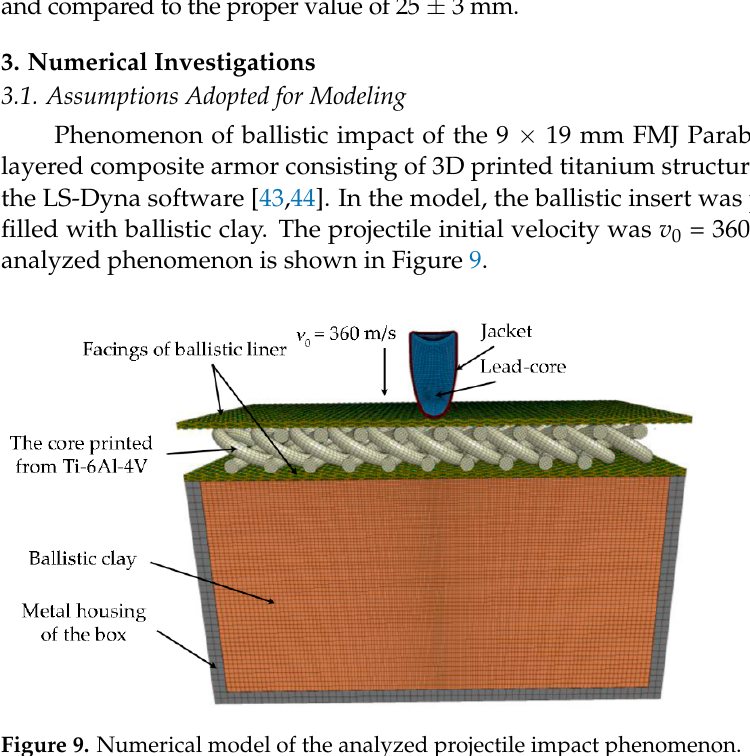
Figure 8. Deformations of the 9 mm FMJ Parabellum projectile obtained in the experiments and simulations: ( a ) impact velocity of 100 m/s; ( b ) impact velocity of 126 m/s and ( c ) impact velocity of 143.8 m/s.